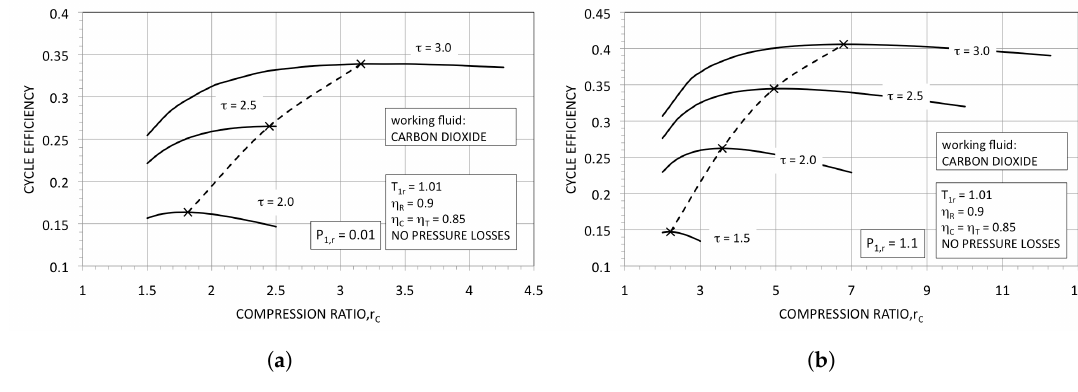
Figure 6. Effect of the temperature ratio τ on the cycle’s thermodynamic efficiency. ( a ) Brayton cycles operating with ideal gas ( P 1, r = 0.01); ( b ) Brayton cycles operating with real strong gas effects in the compression phase ( P 1, r = 1.01). The minimum reduced temperature T 1, r is fixed.